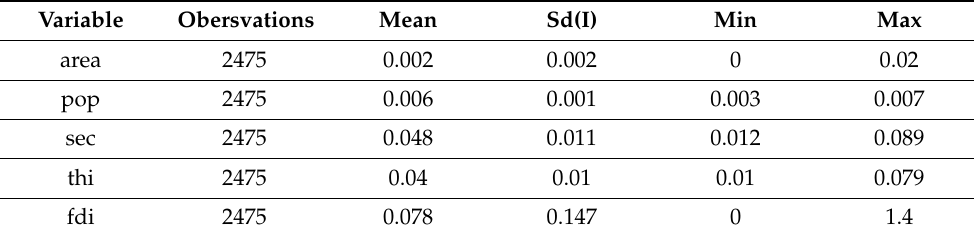
Table 1. Results of Descriptive